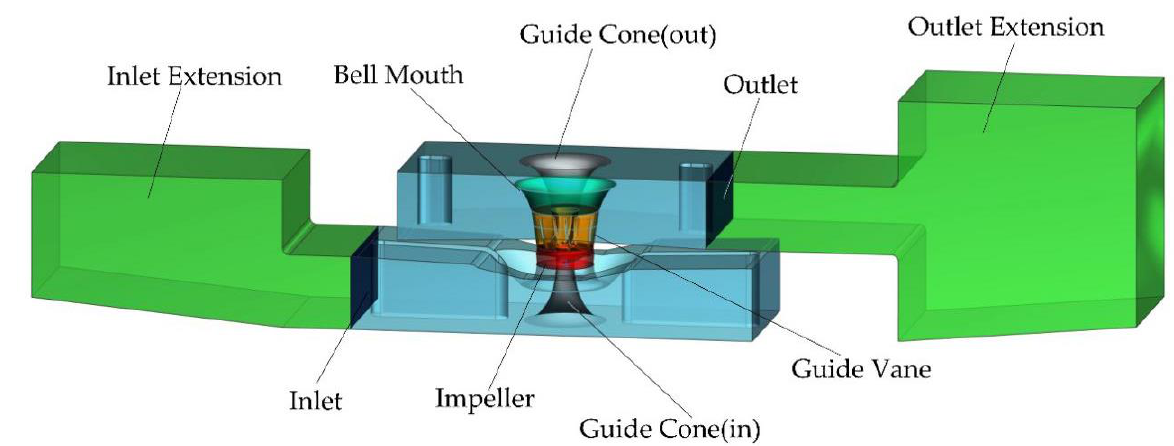
Figure 1. Three-dimensional model of the full flow channel of the pump.